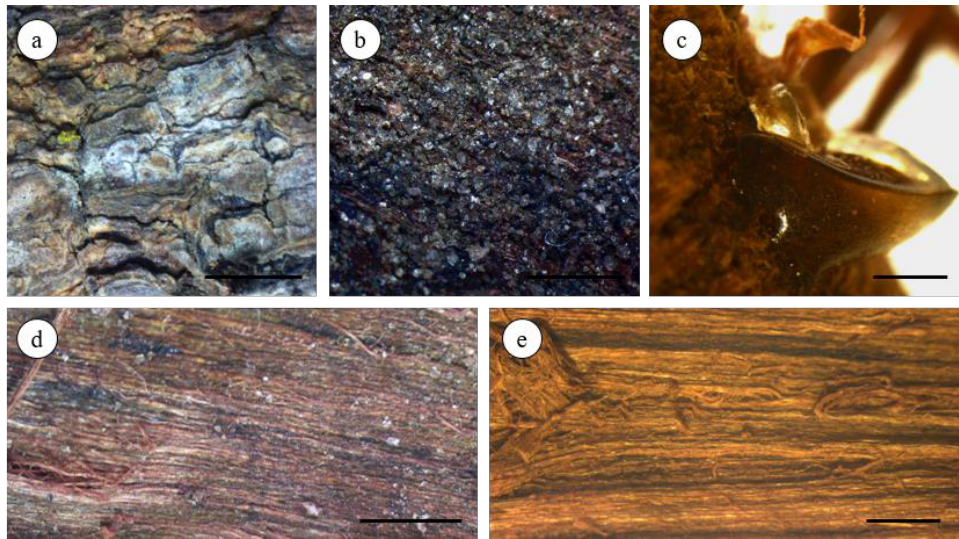
Figure 2. Stereomicroscopy photographs of A. occidentale stem bark. Outer surface with ( a ) greyish lichens and yellow moss; ( b ) calcium oxalate crystals; ( c ) topaz-colored gum resin; ( d ) dark brown inner surface of white AoB; ( e ) reddish-brown inner surface of red AoB. scale bar: ( a , d , e ) = 2 mm; ( b ) = 500 µm; ( c ) = 1 mm.